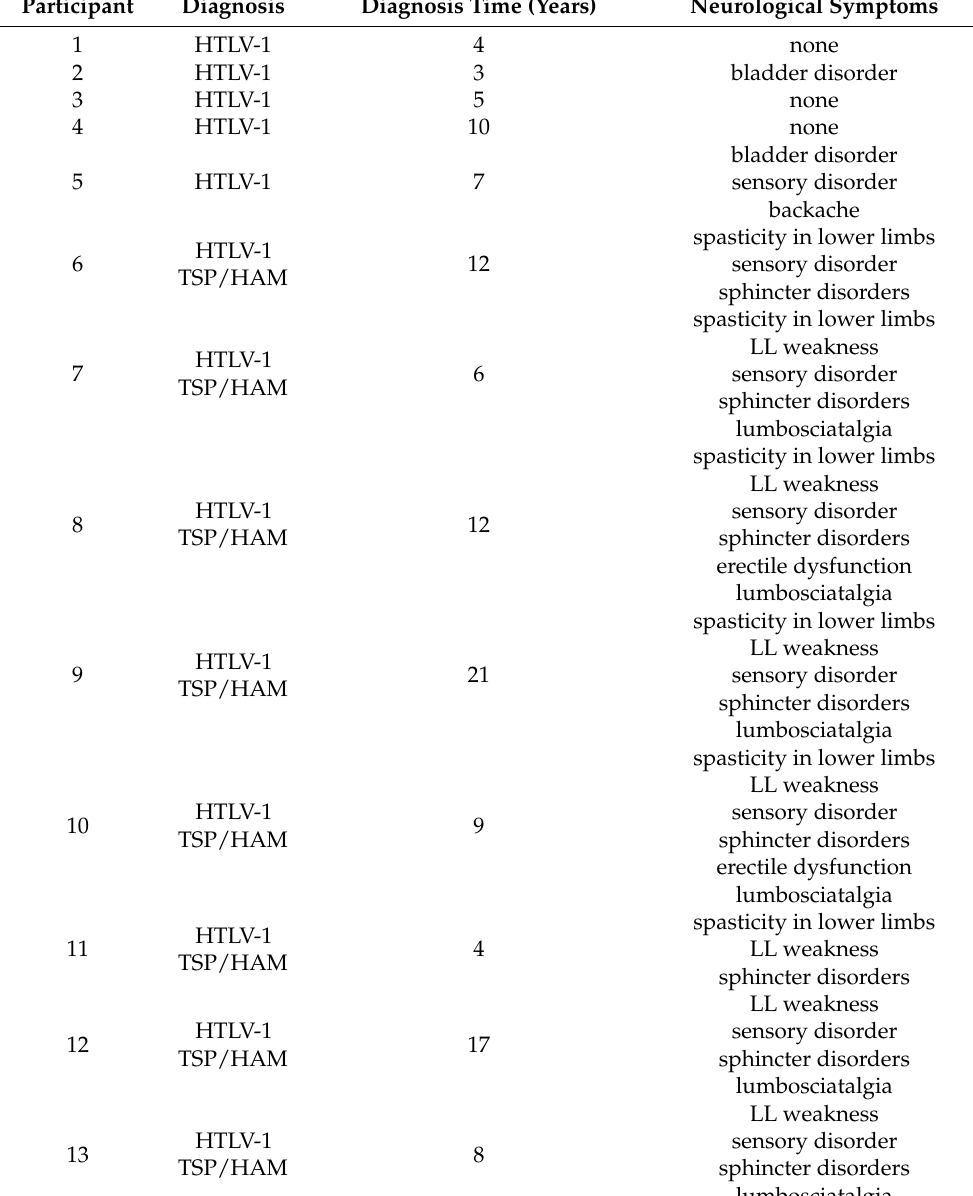
Table 1. Characterization of the infected group in terms of diagnosis time and neurological